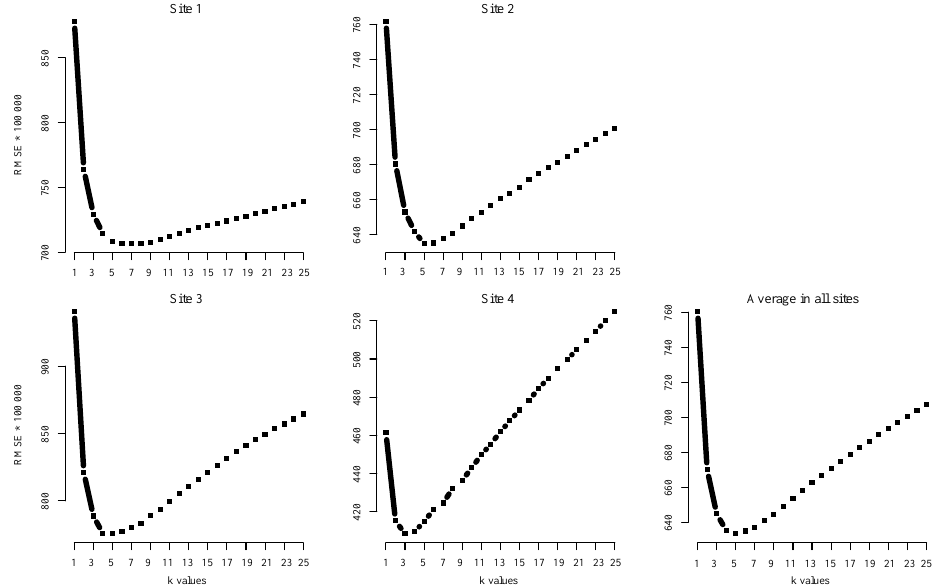
Figure 4. Dependence of gap-filling accuracy on k value in terms of RMSE in the four sites. The train- ing and test datasets were set identical with a number of 10,000 for each k tuning experiment. There was no overlap between the training and test datasets. The four sites had minimum RMSE when k was equal to 7, 5, 5, and 3, respectively, reaching a minima average at k = 5 for all sites. RMSE was multiplied by